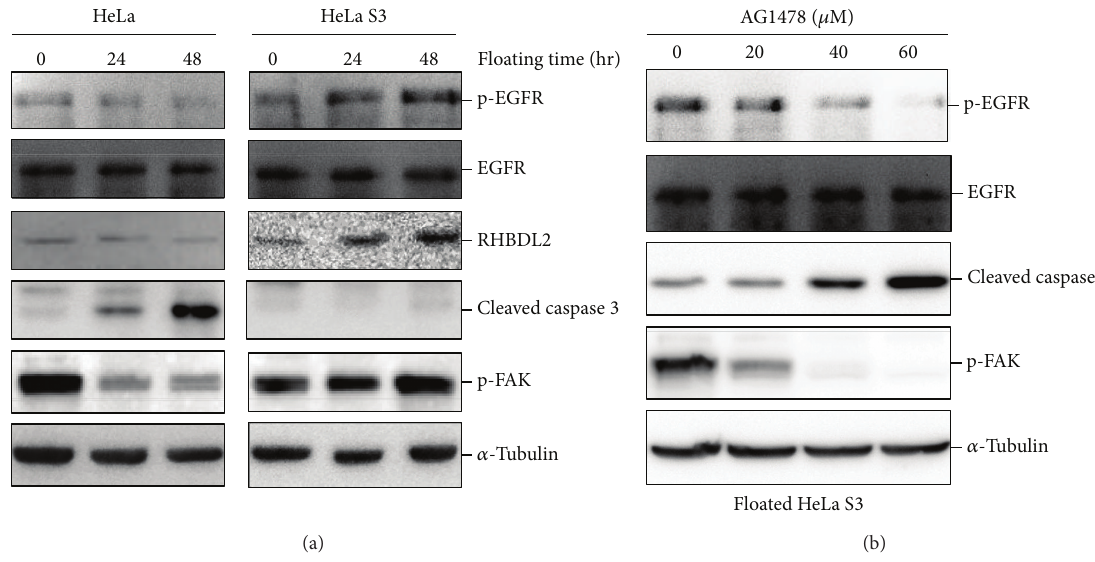
Figure 4: RHBDL2 mediated anoikis resistance through EGFR signaling in long-term suspension-cultured HeLa S3 cells. (a) Suspension culture triggering the phosphorylation of EGFR and FAK was detected by Western blotting analysis. (b) The activation of caspase 3 and FAK in HeLa S3 cells cultured in a 48-hour suspension condition and treated with various doses of EGFR inhibitor (AG1478) were measured.